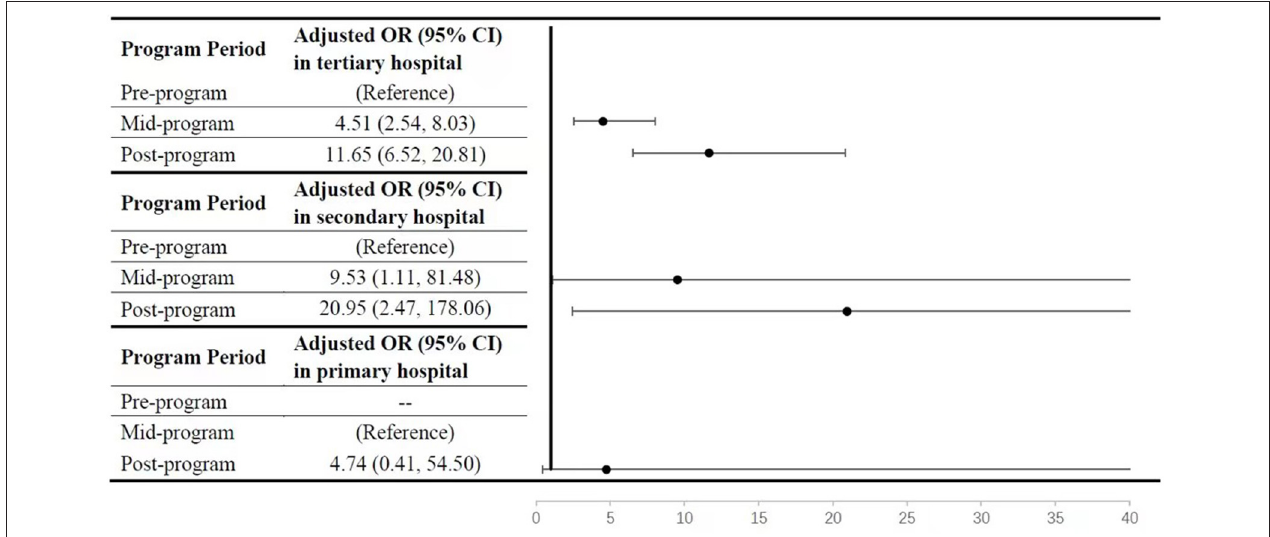
FIGURE 3 | Multivariate logistic regression analysis for different time-interval associated with the prenatal diagnosis for major congenital heart diseases stratified by different hospital levels, 2004–2015. The multivariable models in different hospital stratification was adjusted by maternal age ( > 35 yrs and ≤ 35 yrs), domestic migrant population (yes/no), maternal education (more than high school/completion of high school/less than high school), total previous live births (0/1/ ≥ 2), family history of CHD (yes/no), maternal diabetes (yes/no), maternal hypertension (yes/no), infant sex (female/male), extra-cardiac/aneuploidy/genetic syndrome (yes/no), and fetus with suspected cardiac abnormality on basic obstetric ultrasound (yes/no). OR, Odds Ratio; CI, confidence